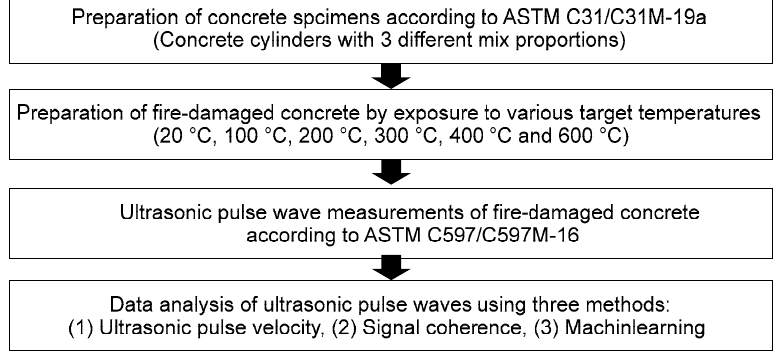
Figure 1. General experimental studies flow for this research.